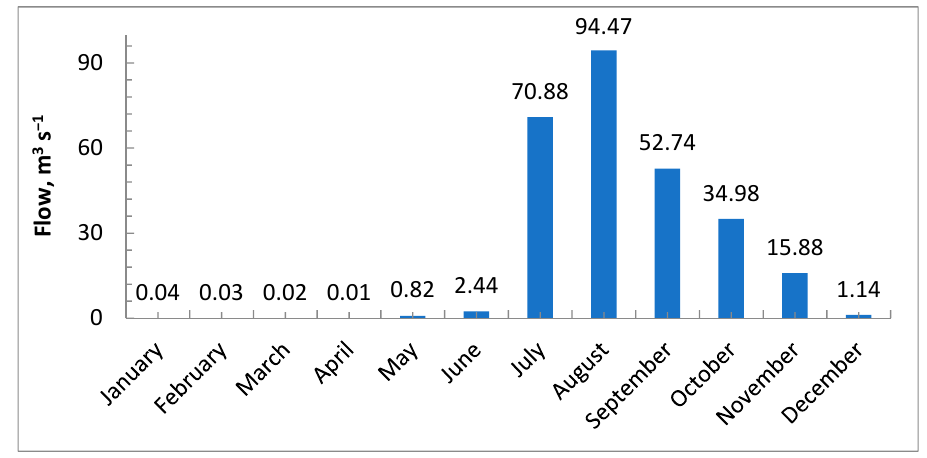
Figure 10. Monthly flow average in m 3 s − 1 of Ribb River since 1981 to 2005.